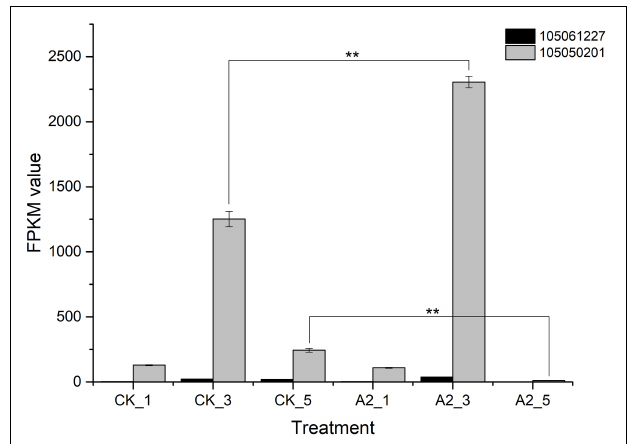
FIGURE 5 | FAD2 expression in CK and A2. **Represents significance at p < 0.01. CK_1: 16 WAP with 0 µ M ABA; CK_3: 20 WAP with 0 µ M ABA; CK_5: 24 WAP with 0 µ M ABA; A2_1: 16 WAP with 20 µ M ABA; A2_3: 20 WAP with 20 µ M ABA; A2_5: 24 WAP with 20 µ M